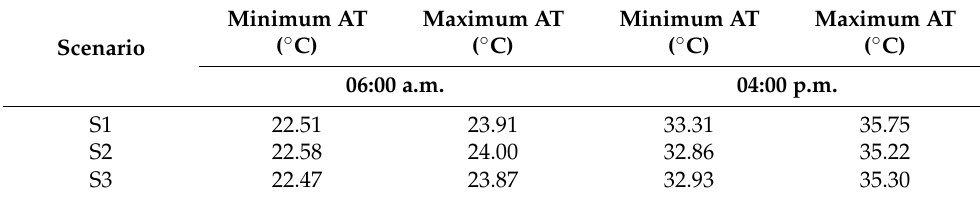
Table 5. Minimum and maximum AT values at 06:00 a.m. and 04:00 p.m.